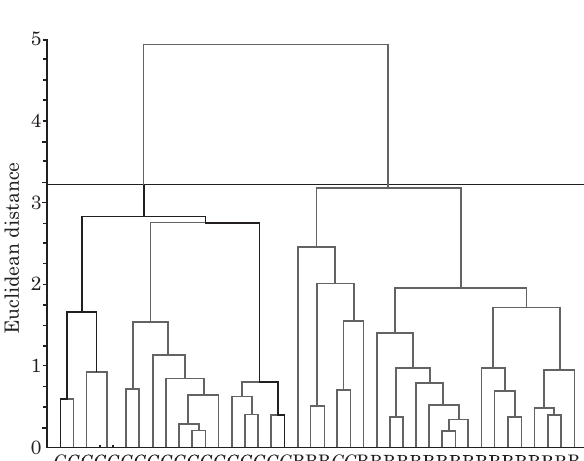
Figure 4. Dendrogram illustrating the mutual relationships between the two harvesting systems considering physical, chemical and mineralogical properties in the 0.00-0.25 m layer of soil. G: mechanical (green) harvesting, B: manual harvesting (with burning). n =